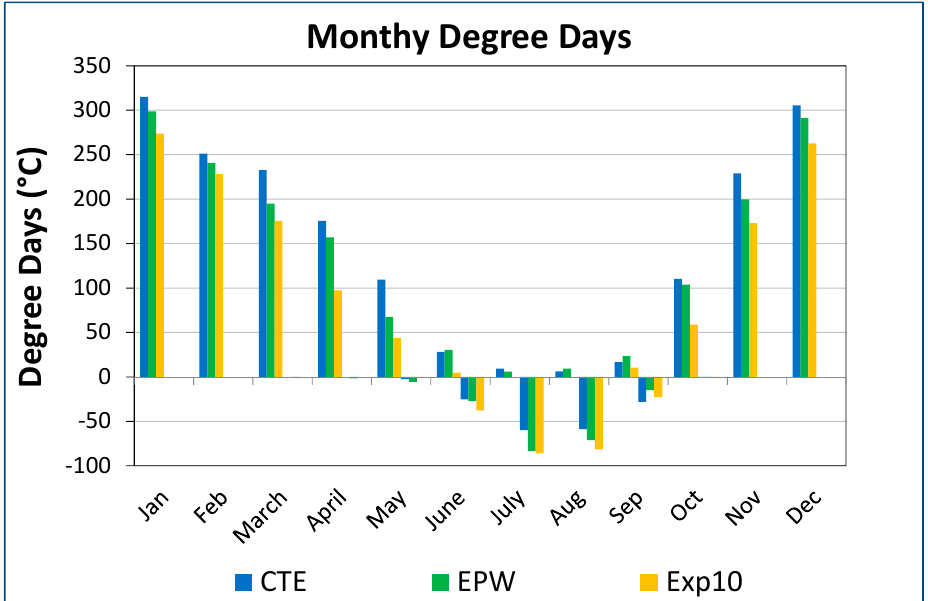
Figure 4. Monthly degree-days obtained for the three climate databases studied of Madrid: CTE, EPW and Exp10.